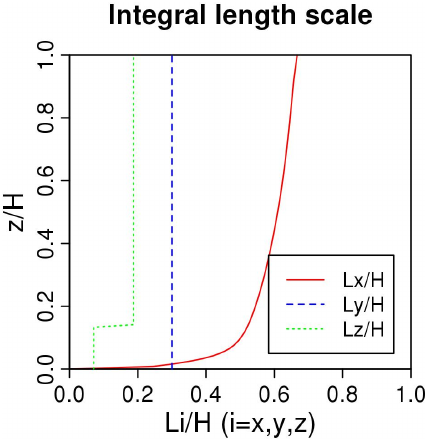
Figure 1. Integral length scales prescribed at the inlet used in the inflow BASE case